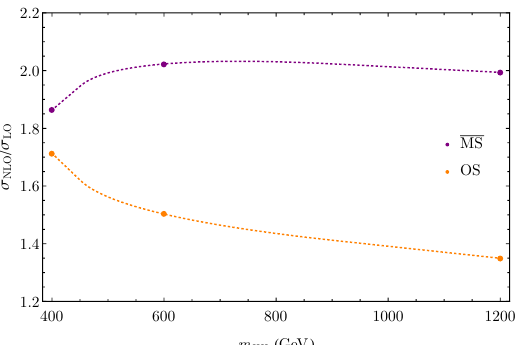
Figure 4 . NLO K -factors for di-Higgs production as a function of m HH in the MS (purple) and OS (orange) schemes. The values, indicated with dots, are taken from ref. [21], and the interpolating curves are shown only for illustrative